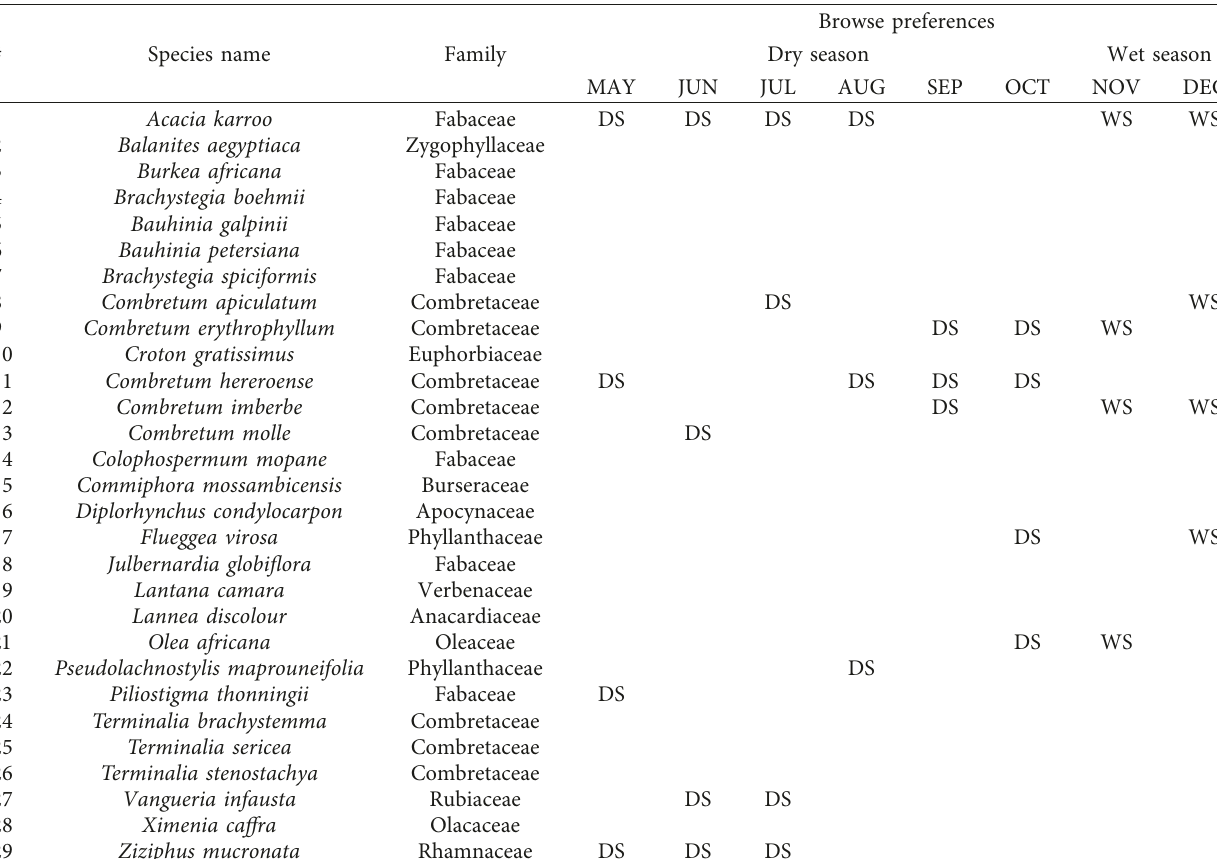
Table 1: Mapping woody species selected by giraffes during the study period in Umfurudzi Park.